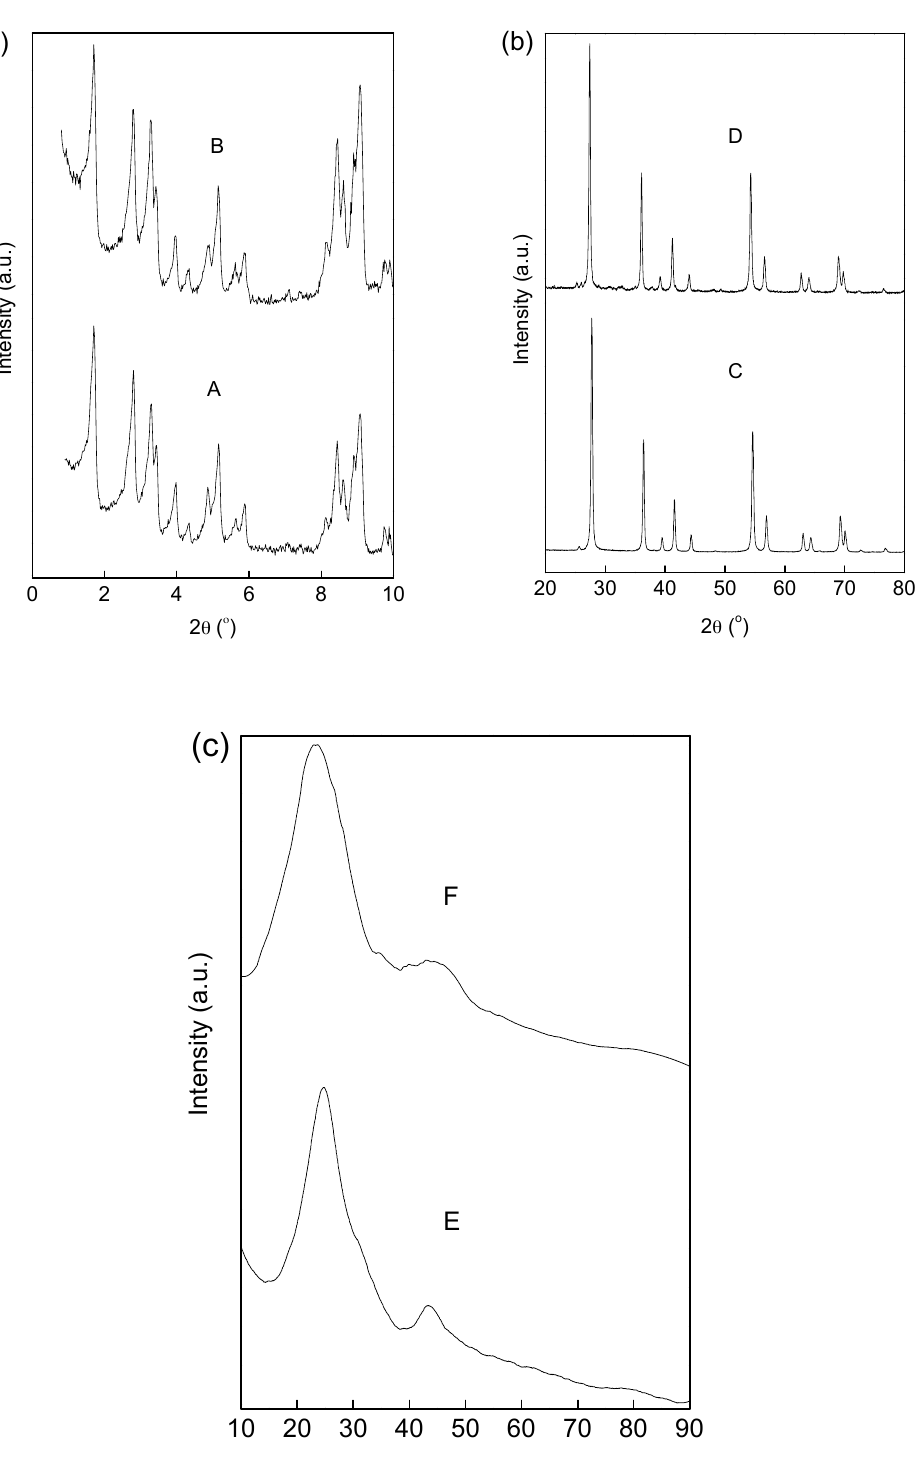
Figure 3. ( a ) XRD patterns of MIL-101 (A) and CuNi / MIL-101 (B); ( b ) XRD patterns of TiO 2 (C) and CuNi / TiO 2 (D); ( c ) XRD patterns of C (E) and CuNi / C (F).